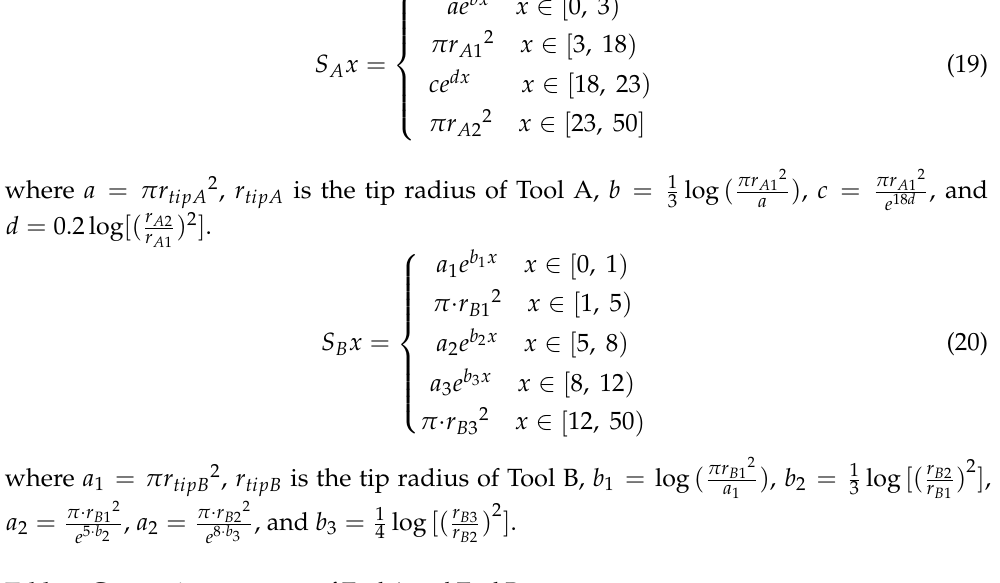
Table 1. Geometric parameters of Tool A and Tool B.